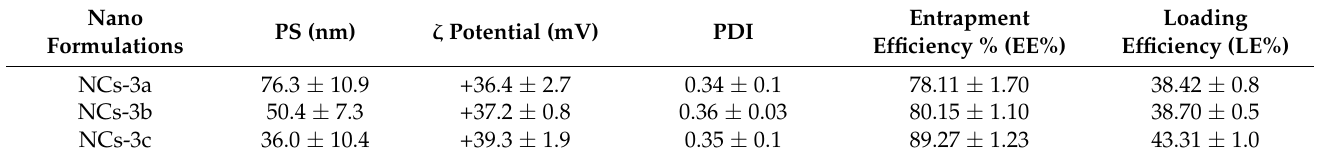
Table 1. Particle size (PS), zeta potential ( ζ potential), percentage of the entrapment efficiency